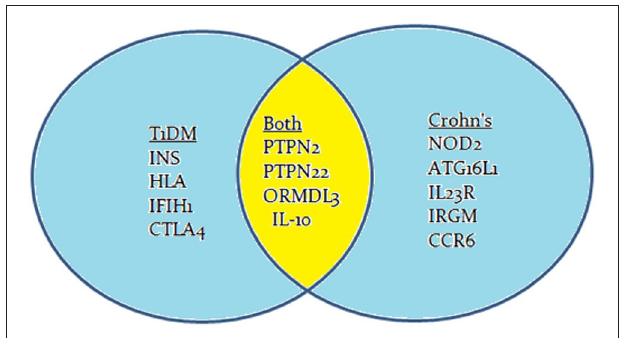
FIGURE 2 | Venn diagram of known susceptibility loci associated with both T1D and Crohn’s disease.